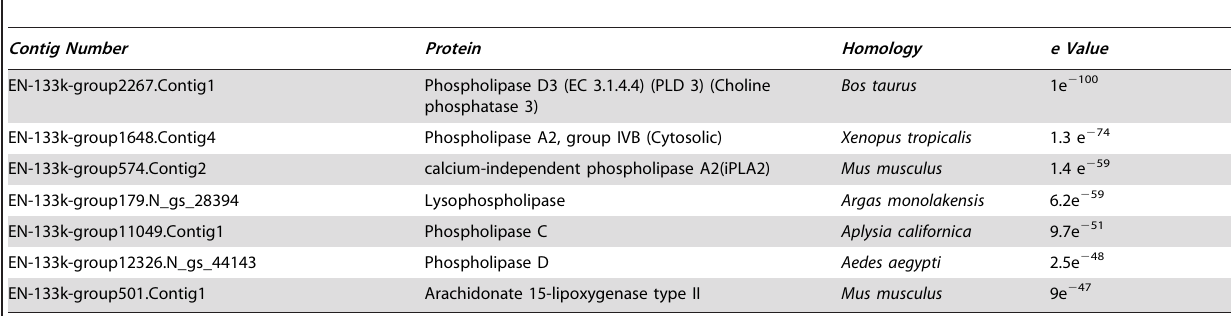
Table 5. Leech Brain phospholipases and lipoxygenases obtained from Hirudo medicinalis nerve cord EST library (http://www.cns.